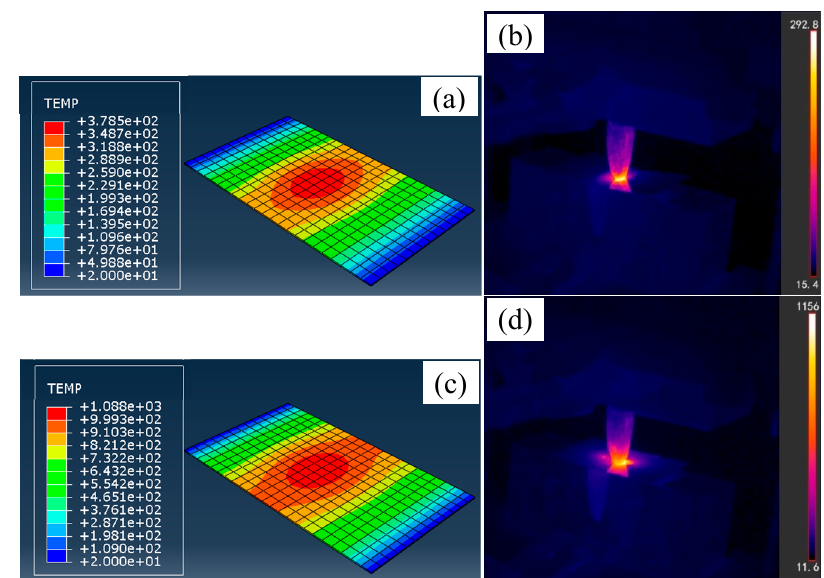
Figure 2. The predicted and measured sheet temperature distributions at different average current densities: ( a ) 4.8 A/mm 2 , prediction, ( b ) 4.8 A/mm 2 , measurement, ( c ) 10.9 A/mm 2 , prediction, ( d ) 10.9 A/mm 2 , measurement.